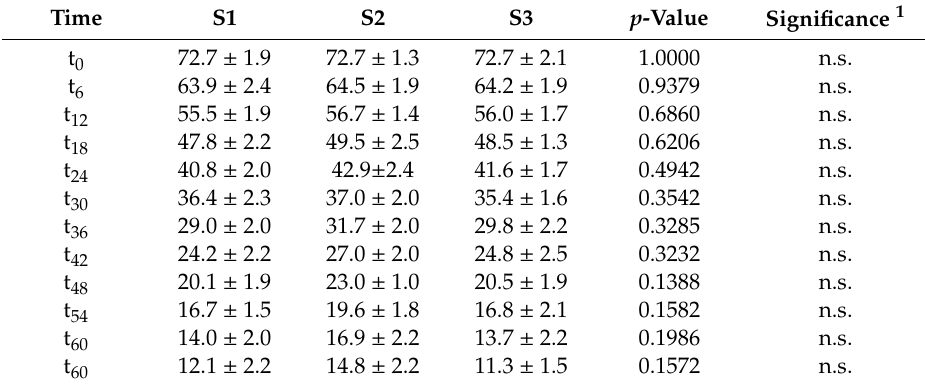
Table 6. Analysis of variance results on moisture content values every six hours (MC) for sage dehydration process in the three tests (S1 = 3 kg / m 2 ; S2 = 4 kg / m 2 and S3 = 5 kg / m 2 ). Data are means ± SD (n =